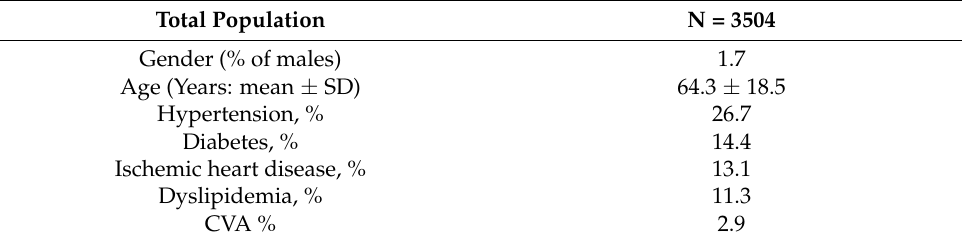
Table 1. The characteristics of the patients. Total Population N = 3504 Gender (% of males) 1.7 Age (Years: mean ± SD) 64.3 ± 18.5 Hypertension, % 26.7 Diabetes, % 14.4 Ischemic heart disease, % 13.1 Dyslipidemia, % 11.3 CVA % 2.9